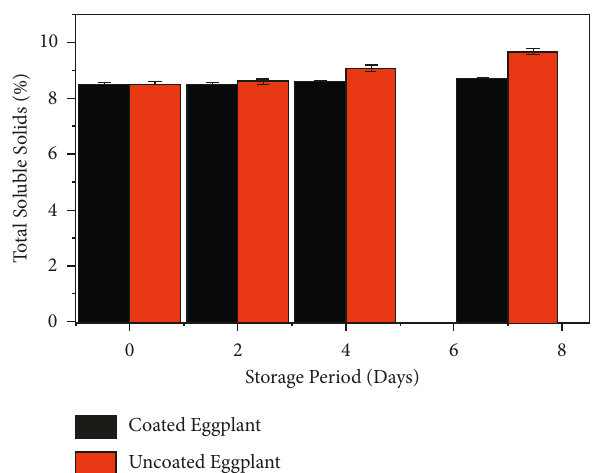
Figure 4: Effect of active coating on the total soluble solids of solanum melongena along with storage time.